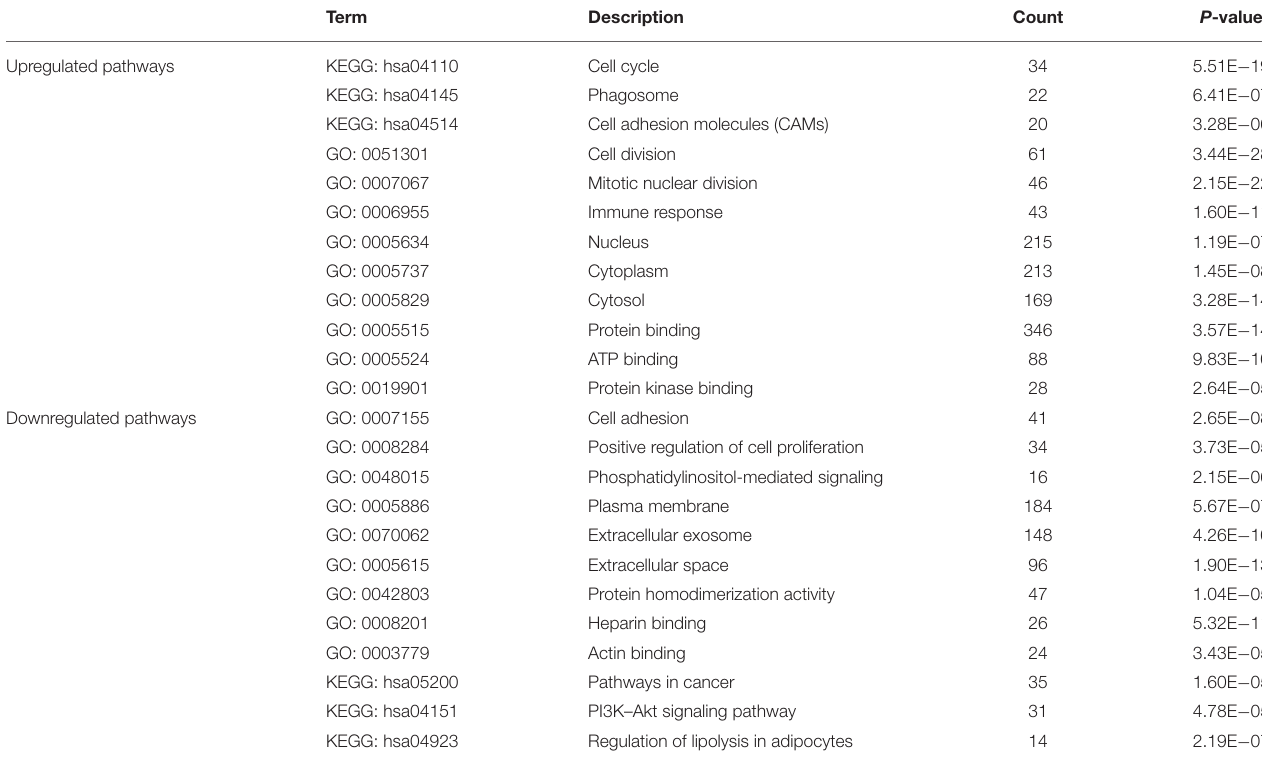
TABLE 2 | GO and KEGG enrichment analyses of the overlapping DEGs. Term Description Count P